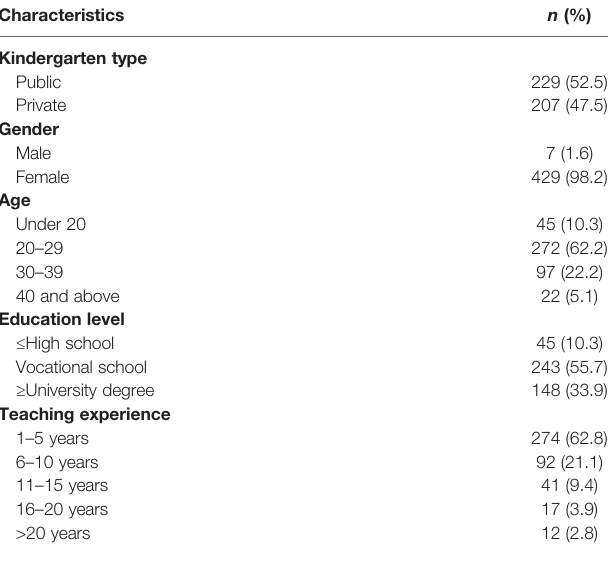
TABLE 1 | Demographic information of kindergarten teacher sample ( n = 436).